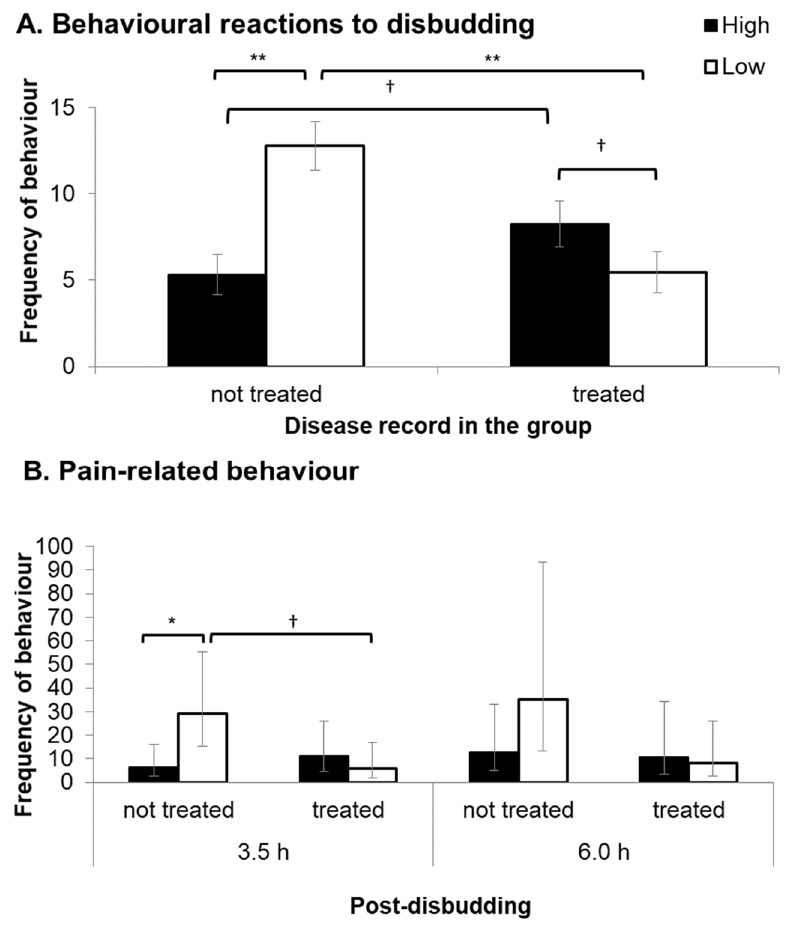
Figure 3. ( A ) Behavioural reactions (mean frequency ± SEM) to the disbudding procedure (head movement and kicking) for calves with no previous disease record in the group (not treated: n = 13 for High and 8 for Low) and calves with a previous disease record in the group (treated: n = 9 for High and 11 for Low). ( B ) Frequency of pain-related behaviours (back-transformed means and 95% Cis (confidence intervals).) displayed by calves with no previous disease record (not treated: n = 13 for High and 8 for Low) and calves with a previous disease record (treated) during live observations (10 min) 3.5 h and 6 h after disbudding. Each symbol indicates † : p < 0.1, *: p < 0.05, and **: p < 0.001.